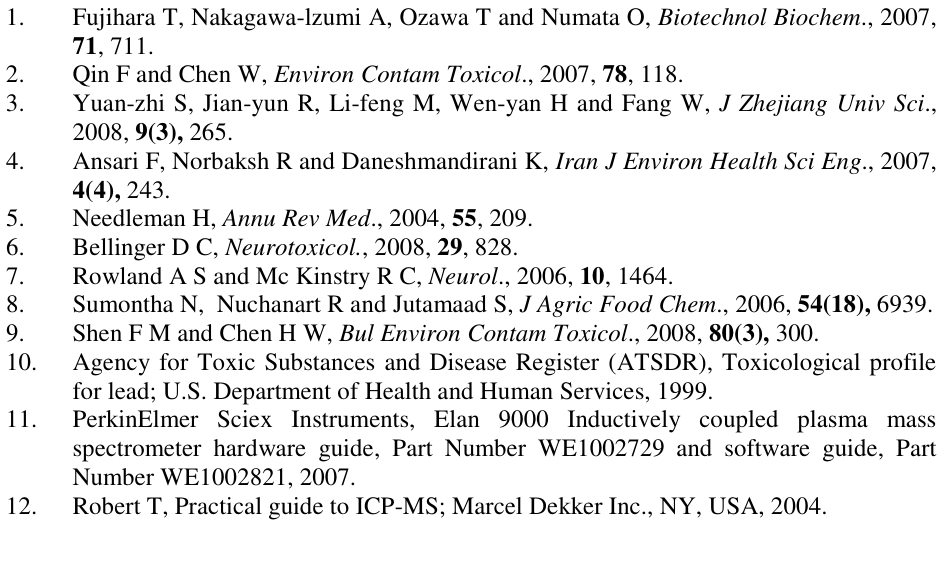
Daily average intake for all genders (ATSDR 1999) 0.001 mg/kg/day 0.001